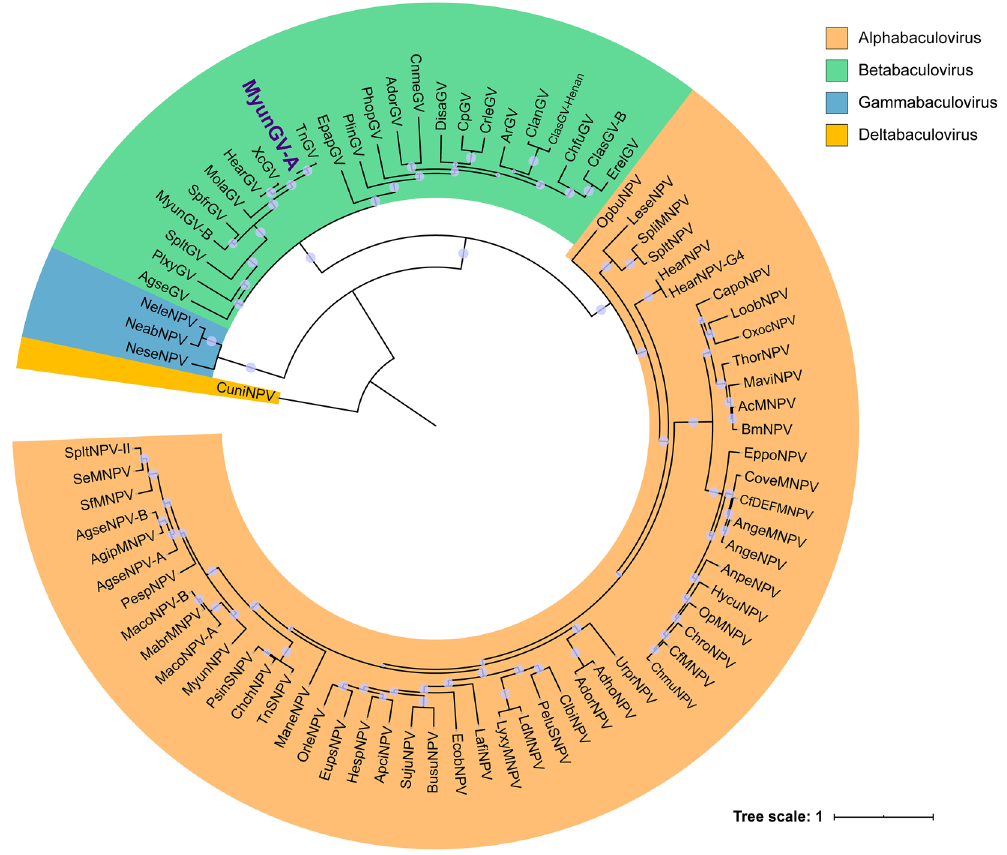
Figure 4. Phylogenetic tree of 82 baculoviruses with complete sequences. The phylogenetic tree was generated using MEGA X 58 software and performed with the maximum likelihood method and JTT matrix-based model 59 . The result was visualized using iToL 60